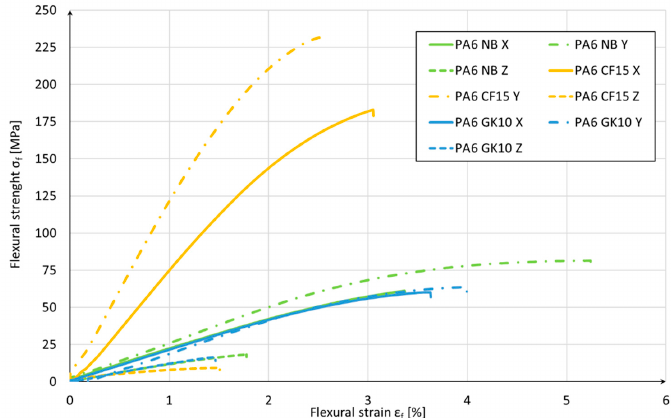
Figure 4. Curves of Flexural Stress ( σ fM ) versus Flexural Strain ( ε f ).